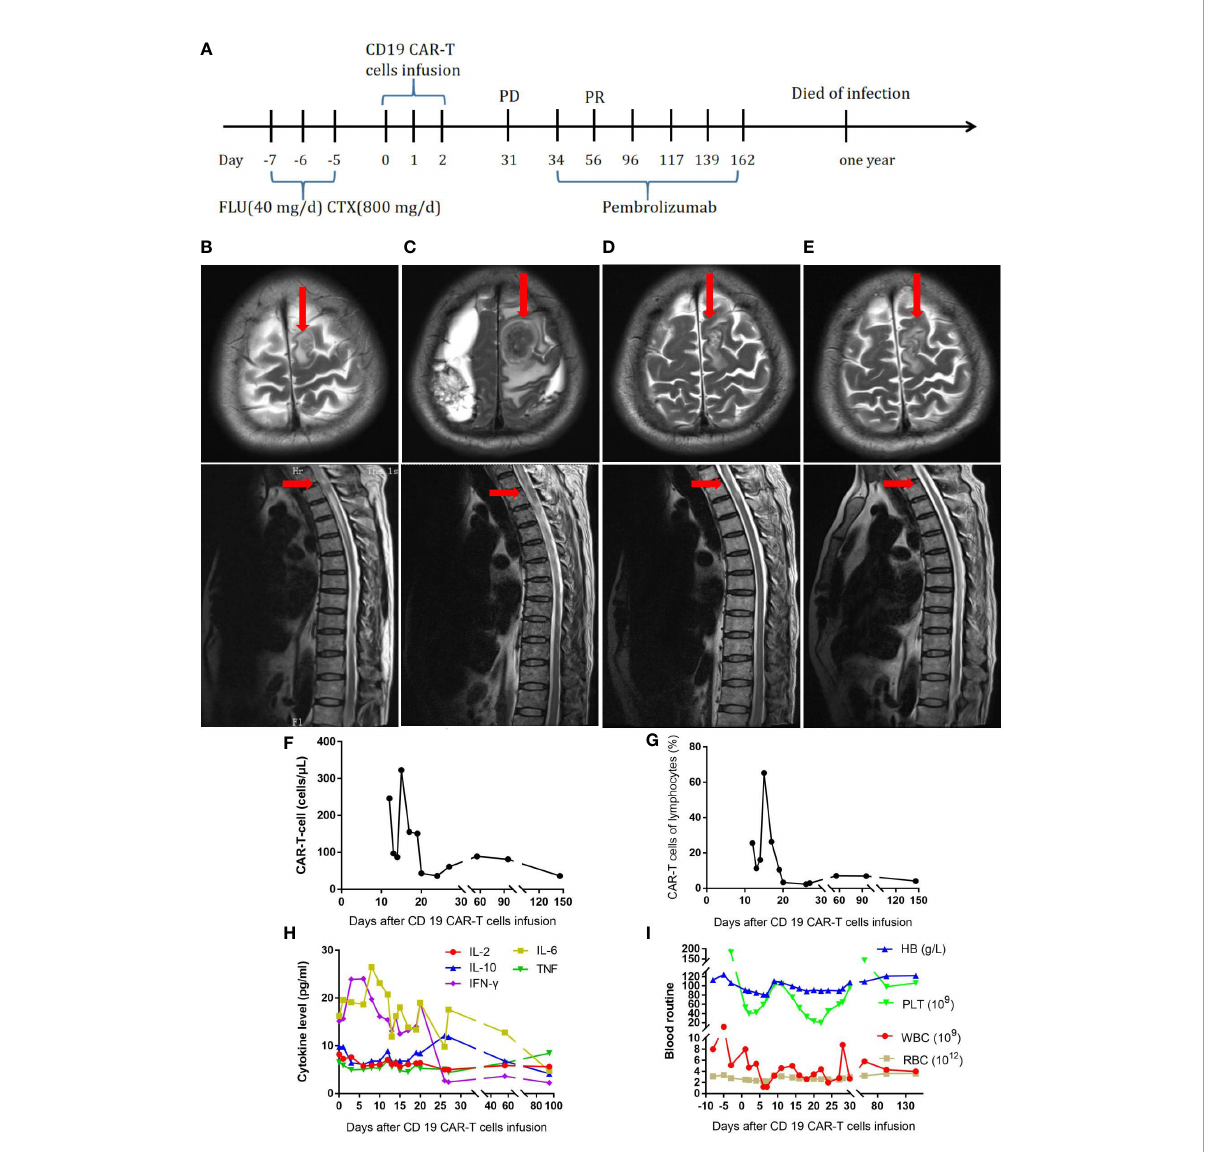
FIGURE 1 (A) Timeline of the treatment process. (B) MRI before CAR-T-cell therapy. (C) MRI thirty-one days after CAR-T-cell therapy. (D) MRI after two doses of pembrolizumab. (E) , MRI ten months after CAR-T-cell therapy. (F) , Resolution of CAR-T-cell expansion after CAR-T-cell infusion. (G) , Percentage of CAR-T cells in lymphocytes after CAR-T-cell infusion. (H) , Cytokine levels after CAR-T-cell infusion. (I) , Routine blood examination before and after CAR-T-cell